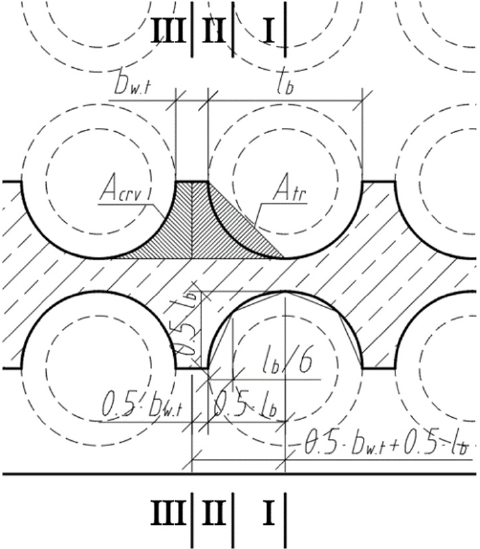
Figure 10. Scheme to determine the position of section II-II.